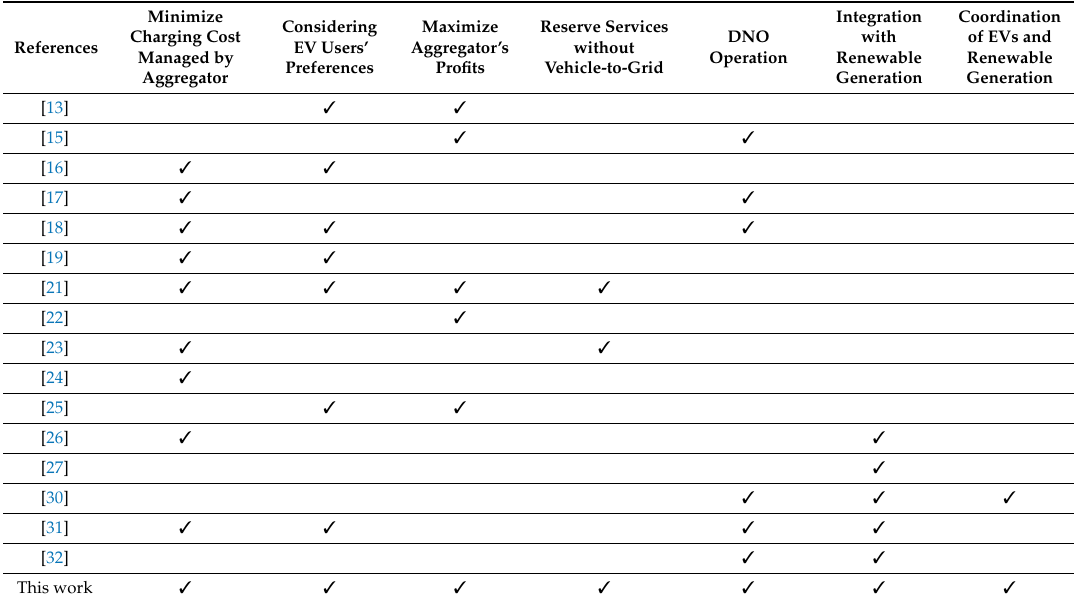
Table 1. Characterization of the literature for the aggregator as an electrical